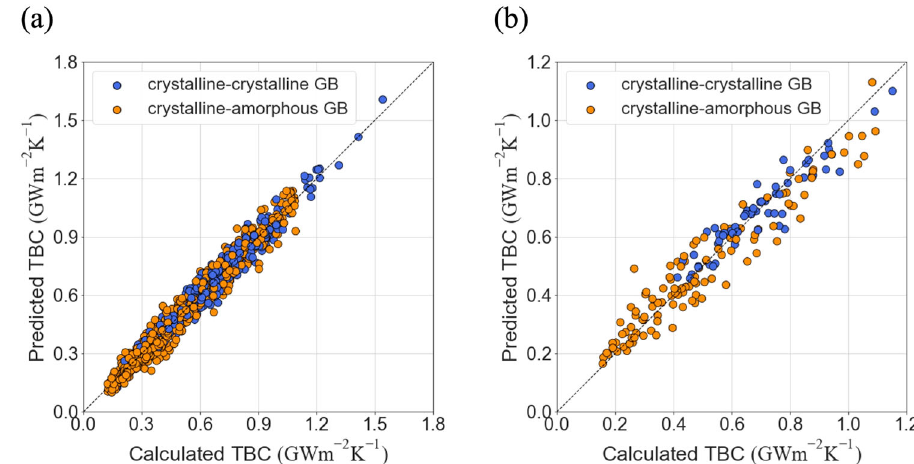
Fig. 3 Parity plot between calculated and predicted thermal boundary conductance (TBC) from the ensemble model. Parity plots of a training set and b test set. For the test set, the model performed better on crystalline – crystalline GBs than on crystalline – amorphous GBs.